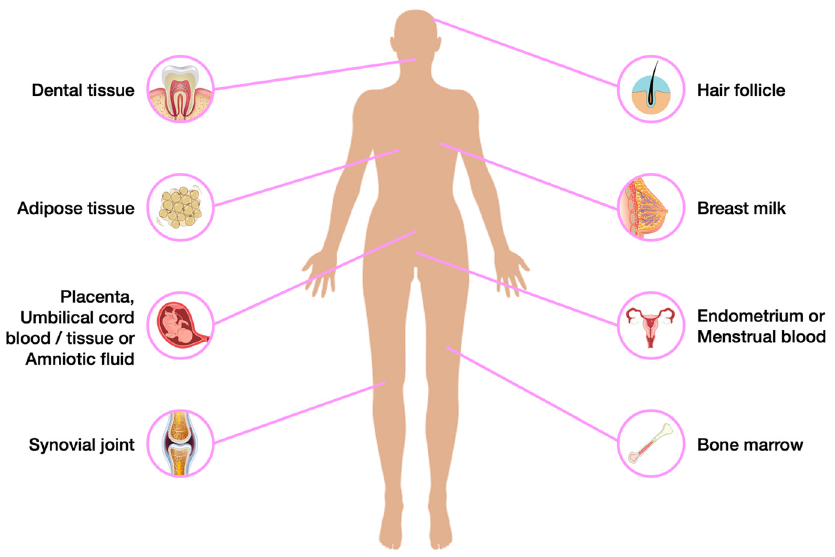
Figure 3. Di ff erent sources of mesenchymal stem cells (MSCs). Figure 3. Different sources of mesenchymal stem cells